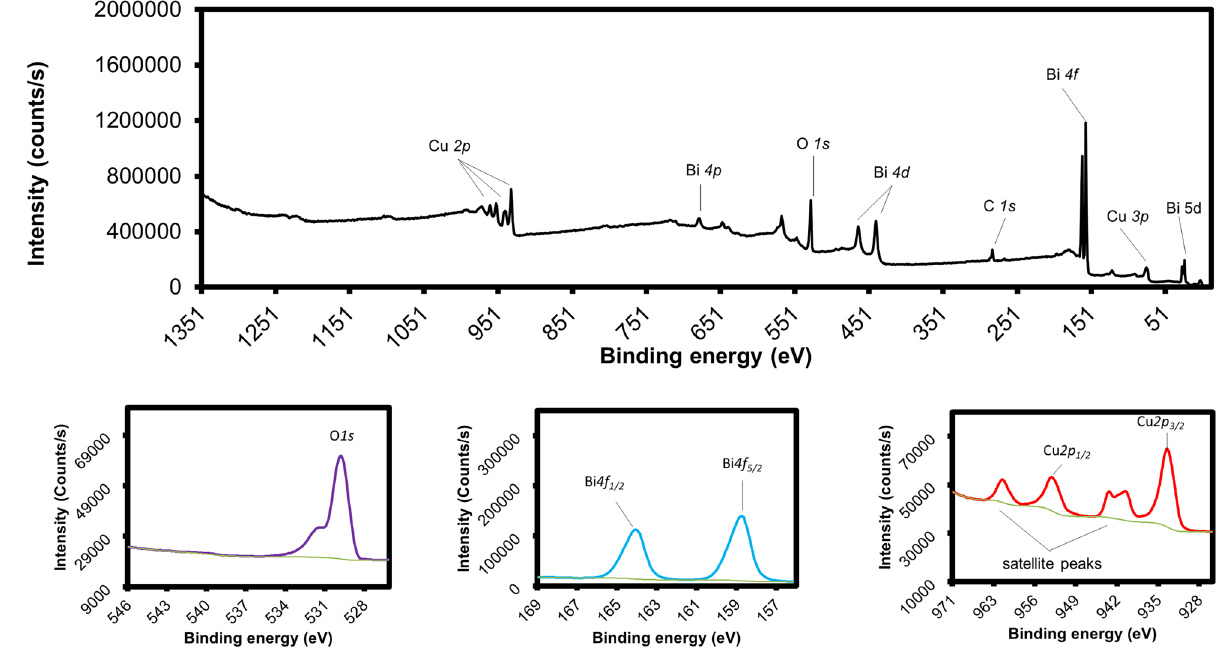
Figure 3. ( a ) X-ray photoelectron spectroscopy (XPS) survey spectrum of sample S15450 with the high- resolution XPS spectra of ( b ) O 1s , ( c ) Bi 4f. , and ( d ) Cu